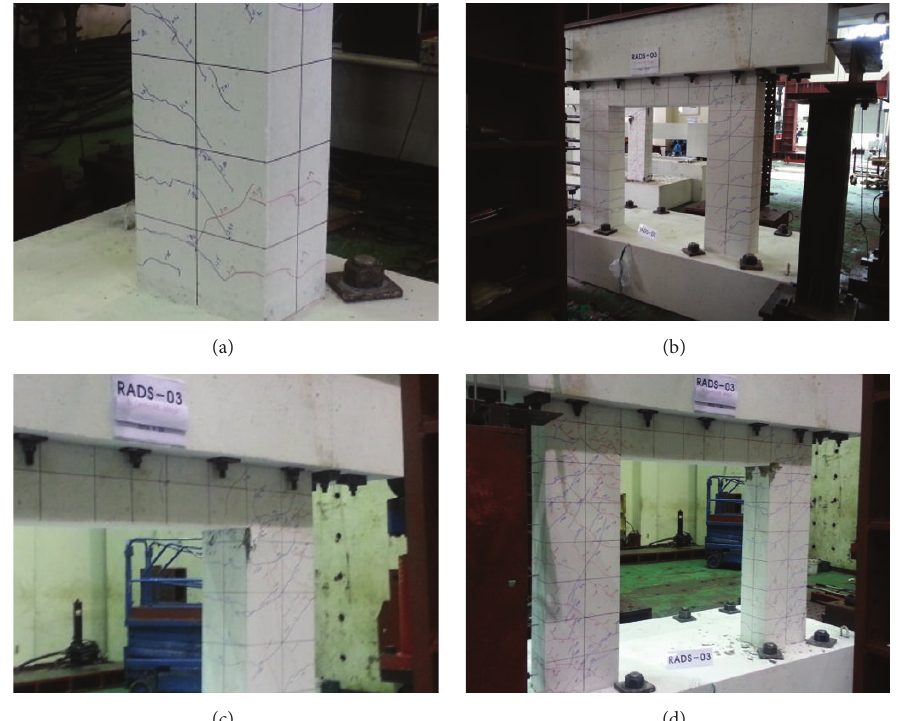
Figure 11: Cracks that appeared in the PD-F specimen during pseudodynamic testing: (a) 2.7 s with lateral displacement of 12mm in 200 gal, (b) the final stage (4 s) in 200 gal, (c) 2.12 s with lateral displacement of − 28.7 mm in 300 gal, and (d) the final stage (4 s) in 300